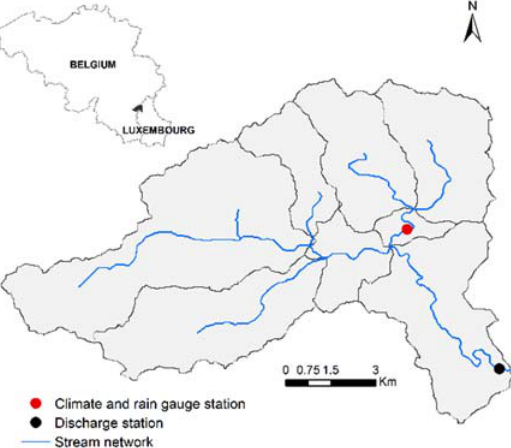
Figure 1. The study area location with its stream network. Meteorological conditions are measured in a daily resolution next to Schimpach, Luxembourg (50°00 ′ 36 ′′ E, 5°50 ′ 56 ′′ N), while the discharge of the Wiltz River is measured at the outlet close to the city of Winseler (49°58 ′ 04 ′′ E, 5°53 ′ 23 ′′ N).